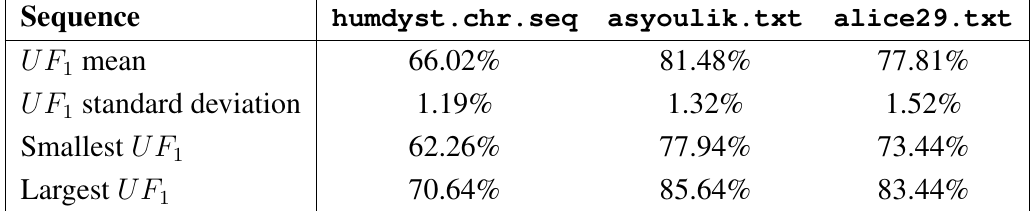
Table 4. Different figures for a sample of 1000 grammars uniformly taken from G